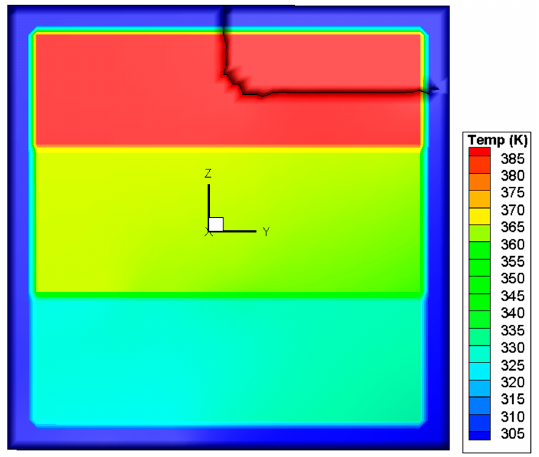
Figure 16. Crack path predicted by the SIF-based maximum circumferential stress criterion.